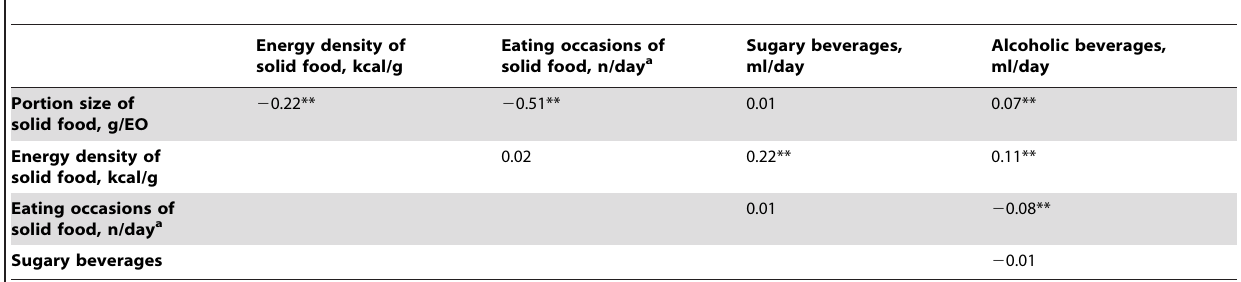
Table 1. Pearson correlation coefficients between food portion size, energy density of food, number of eating occasions, and beverage